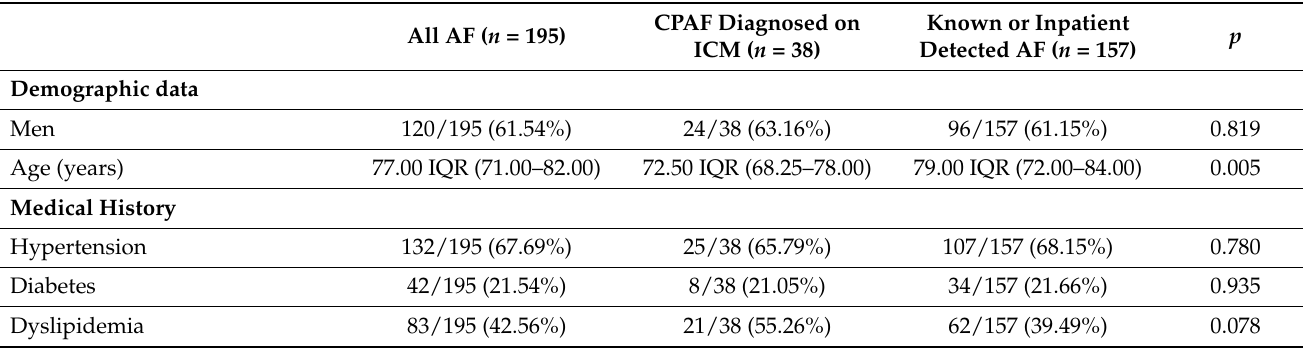
Table 2. Comparison of ESUS patient with CPAF diagnosed on ICM and stroke patients with KIDAF. (Missing data is in